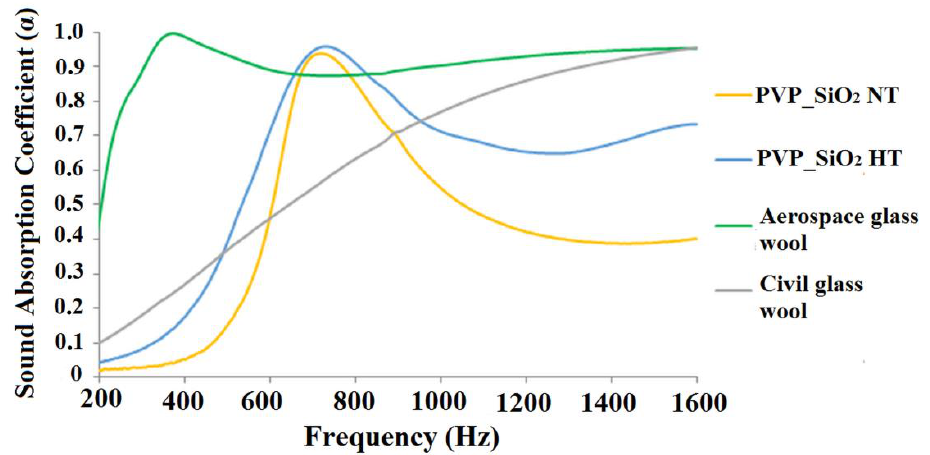
Figure 15. Comparison of the acoustical behaviors of electrospun PVP / silica mats and glass wool samples marketed in civil and aerospace engineering fields of same mass (7.85 g).